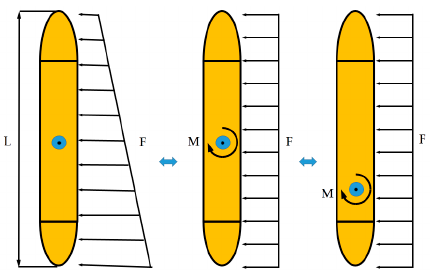
Figure 6. The equivalent relationship between uneven force, uniform force with torque and torque- center-position changes.